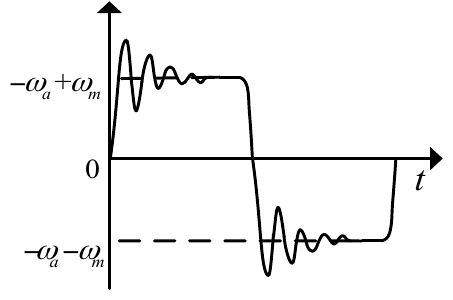
Figure 6. The rotation angular rate of rotary mechanism.